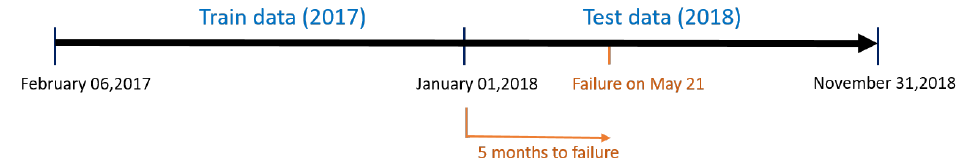
Figure 12. WT2 (WT number 2 in the wind farm) data for training and test.